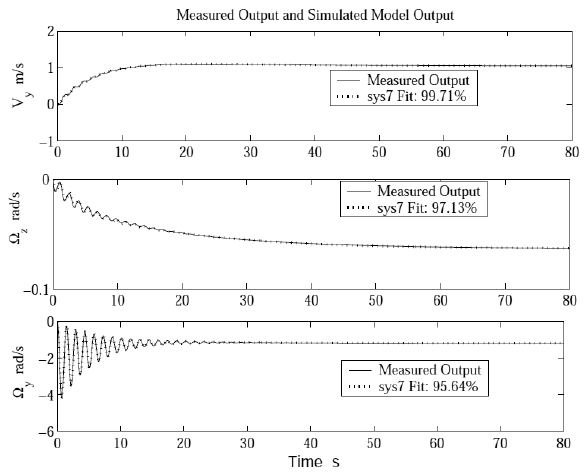
Fig. 4 Output from the simulation